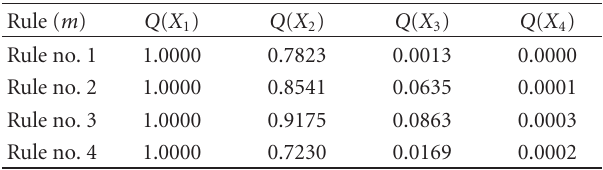
Table 6: Estimated Q